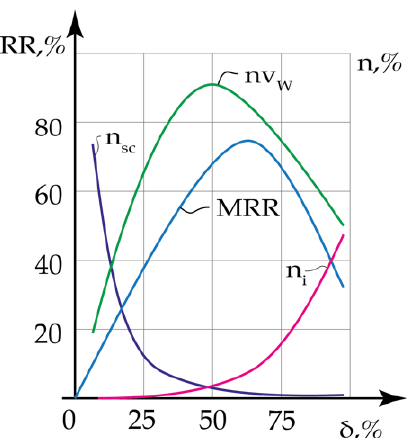
Figure 2. Dependence of the material removal rate (MRR) of the EDM process and the number (percentage of the maximum) of working pulses n w , idle pulses n i and short-circuit pulses n sc on the IEG parameter δ .